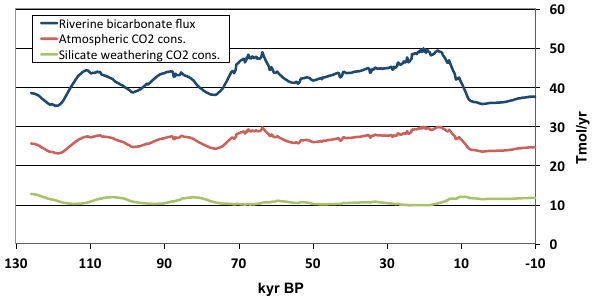
Fig. 7. Dynamics of the riverine bicarbonate flux (blue), the global atmospheric CO 2 consumption rate (brown) and silicate weath- ering CO 2 consumption rate (green) in the PCBL simulation (in T mol yr − 1 ).